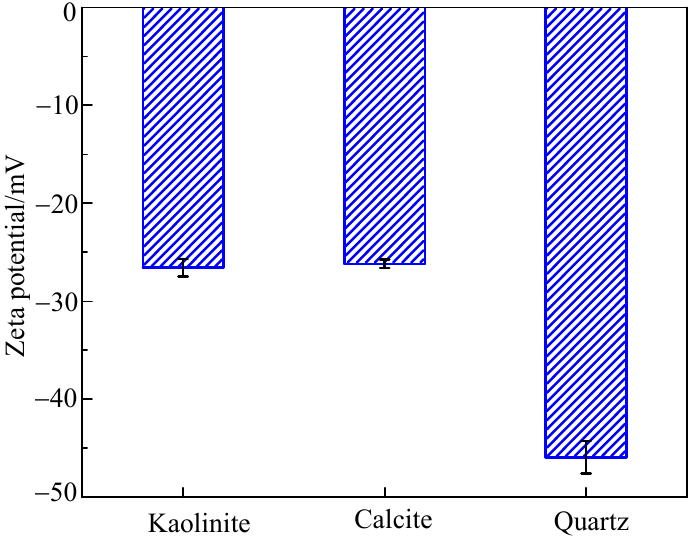
Figure 3. Zeta potential of kaolinite, calcite, and quartz at pH 9.5.